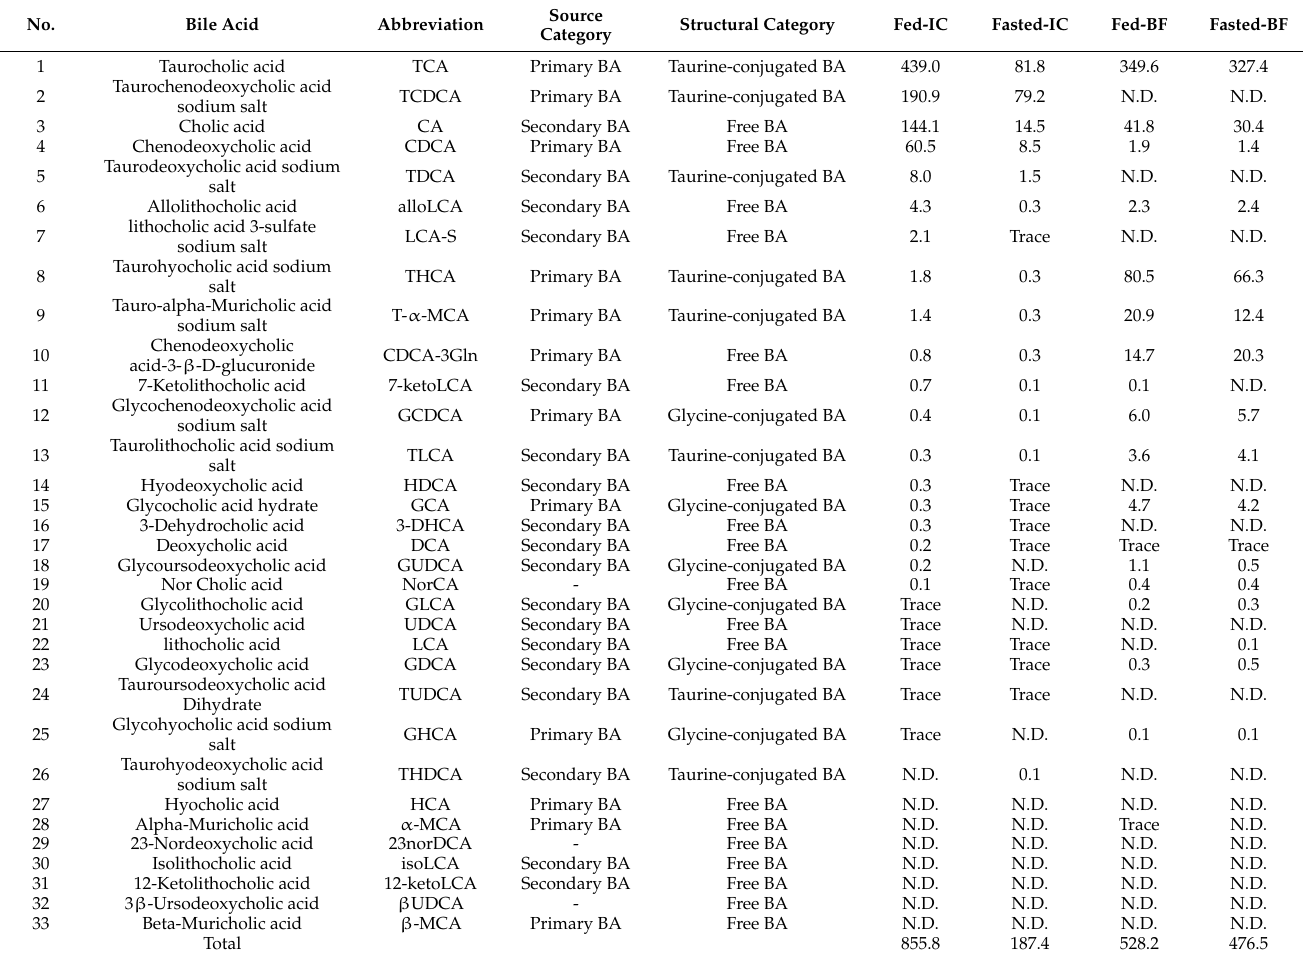
Table 1. The concentrations of 33 BAs/BA salts in different samples